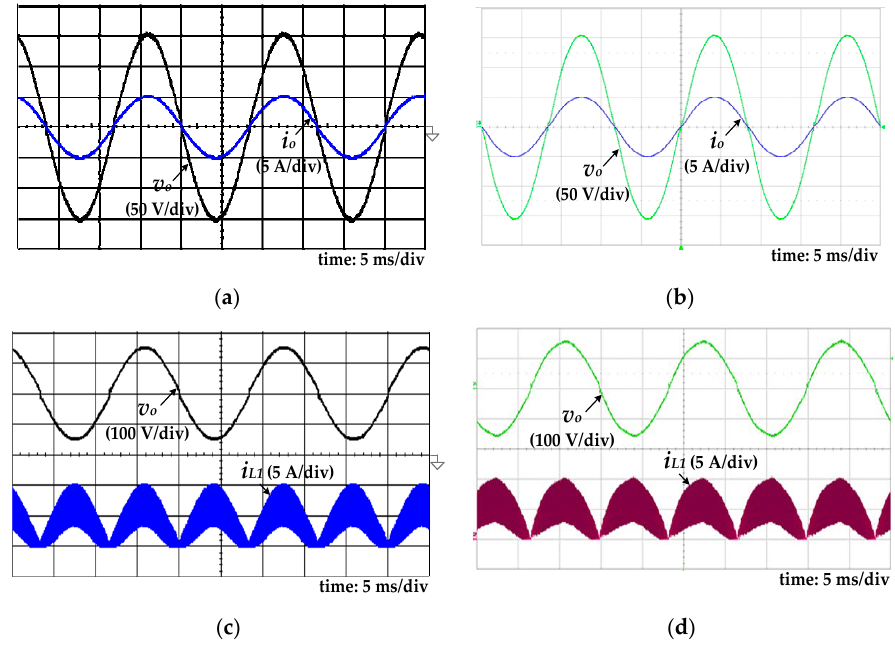
Figure 9. ( a ) Simulation waveforms of v o and i o , ( b ) measured waveforms of v o and i o , ( c ) simulation waveforms of v o and i L 1 , and ( d ) measured waveforms of v o and i L 1 , at 48 V input voltage and a full load of 400 W.